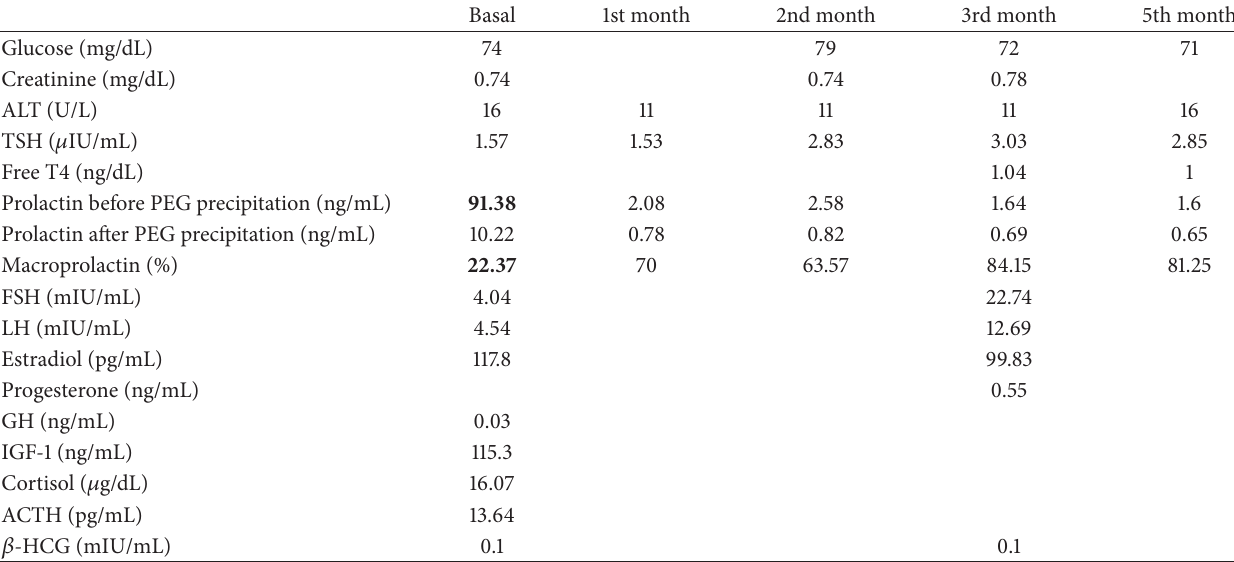
Table 1: Biochemical and hormonal profile of the